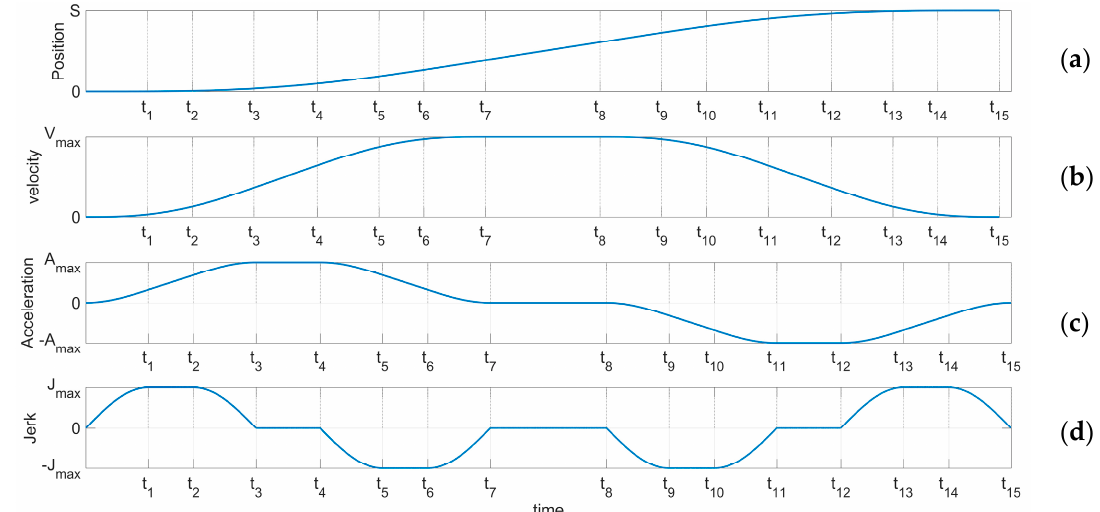
Figure 8. ( a ) Displacement of the 15-segment S curve over time. ( b ) Velocity of the 15-segment S curve over time. ( c ) Acceleration of the 15-segment S curve over time. ( d ) Jerk of 15-segment S curve over time.